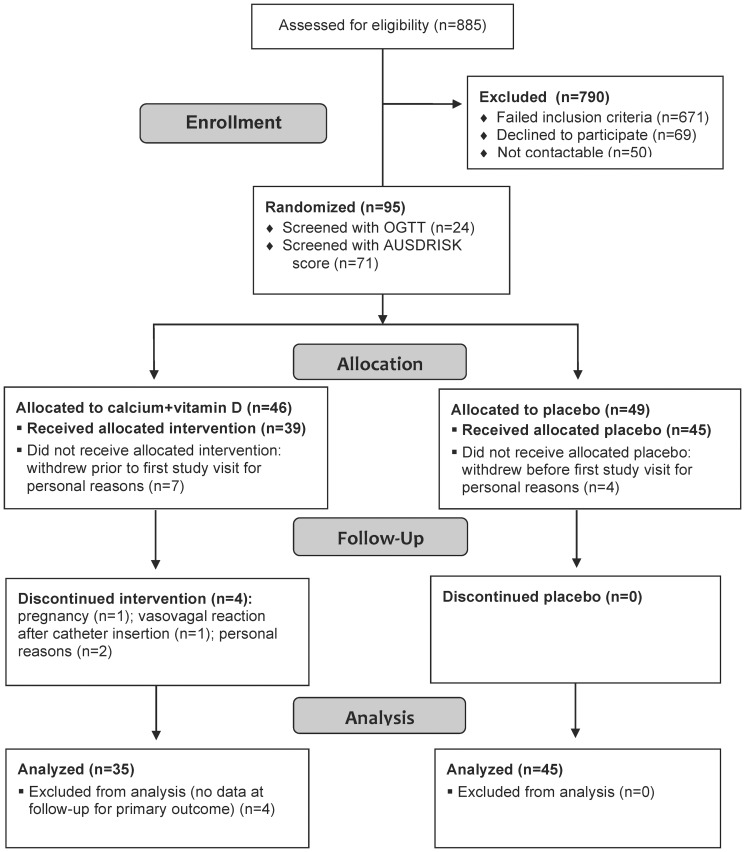
Flowchart showing participant enrollment, allocation, follow-up and analysis.